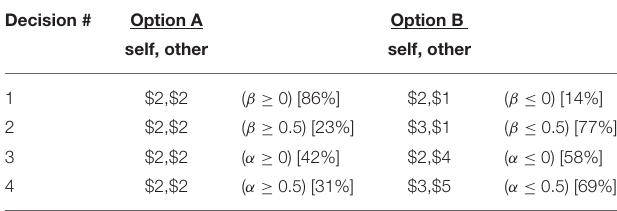
TABLE 1 | Decisions in the social preferences task (Study